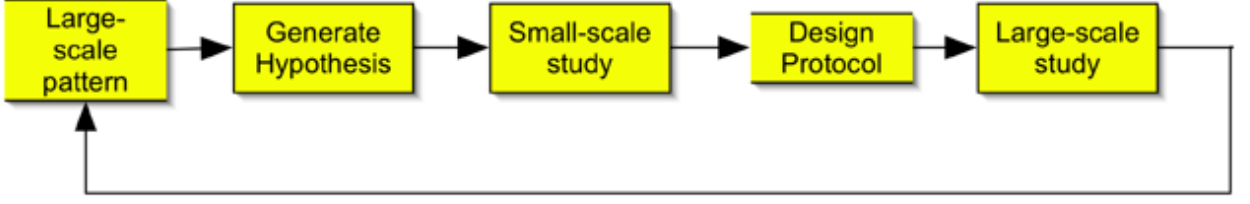
Fig. 1. Schematic showing alternating extensive, broadscale and intensive, fine-scale studies to address multiple stressors over multiple geographic extents. Broadscale, volunteer-based studies allow the documentation of patterns of population-level response to stressors, whereas fine-scale intensive studies can elucidate the processes that lead to observed patterns. Fine-scale studies are also used to develop and test protocols for broadscale